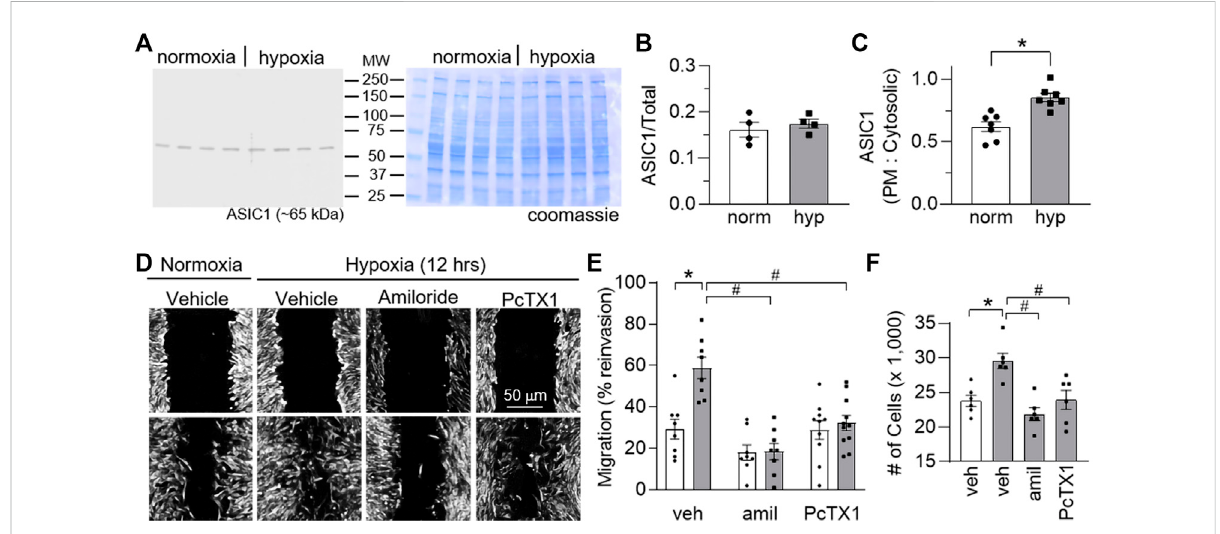
FIGURE 8 ASIC1 contributes to human PASMC migration and proliferation. (A) Representative Western blots of ASIC1 (predicted ~65 kDa) and corresponding coomassie-stained blot and (B) summary data showing ASIC1 expression (normalized to entire lane on coomassie-stained blot) in human PASMC (hPASMC) exposed to normoxia (norm, 5% CO 2 , 95% air; white bars/circles) or 12 h hypoxia (hyp, 5% CO 2 , 2% O 2 ; grey bars/squares). Scanned images ofthe fi lmwereconvertedto greyscaleand adjustedfor brightness/contrast. (C) Summary data showing Western blot analysis for biotinylated (plasma membrane) and cytosolic ASIC1 protein expression in hPASMC exposed to normoxia or hypoxia. (D) Bright fi eld images of hPASMCimmediatelyfollowingthescratch(baselinetime0;toprowofimages)or12